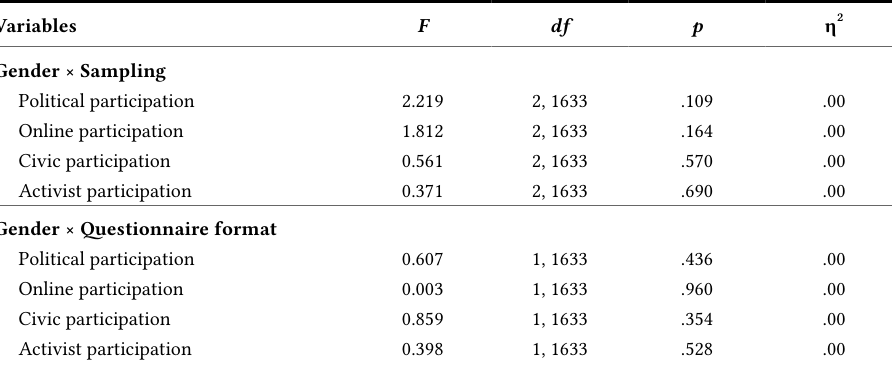
Results From Multivariate General Linear Model for the Interaction Between Gender and Sampling and Between Gender and Questionnaire Format